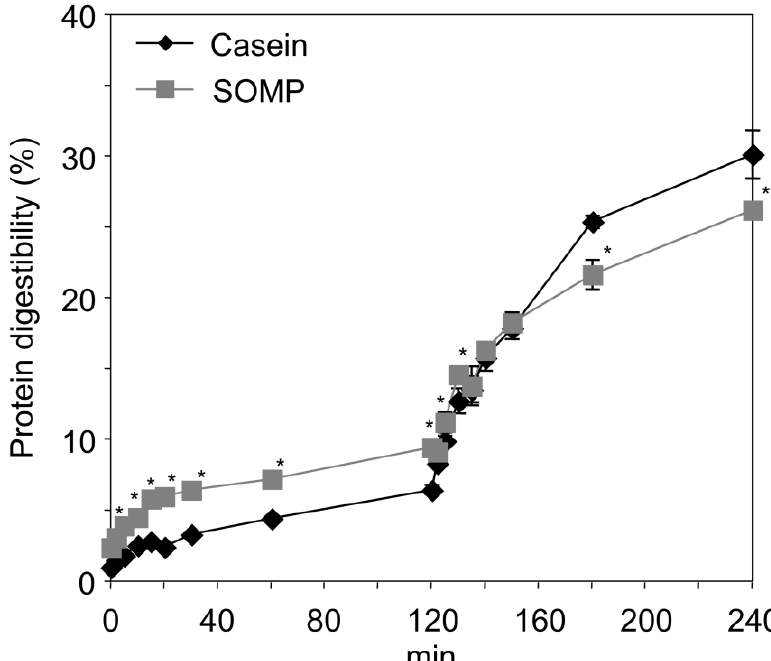
Figure 2. Course of protein digestibility of casein and SOMP using pepsin (added at time 0 min) and pancreatin (added at time 120